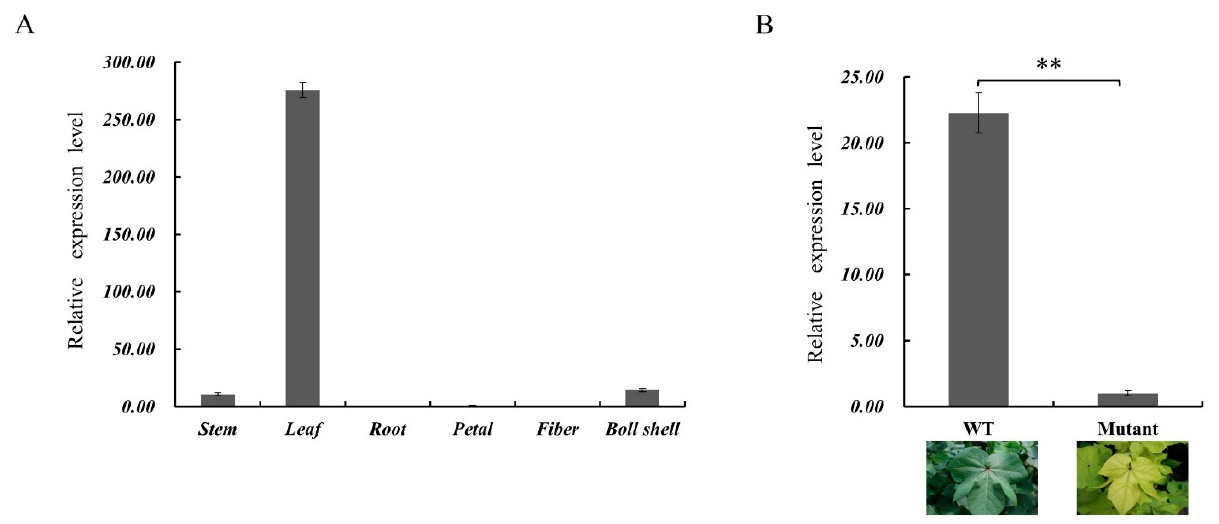
Figure 7. Expression analysis of GhSBPase gene in different tissues ( A ) and yellow-green leaf mutant ( B ) of cotton. ** p < 0.01.